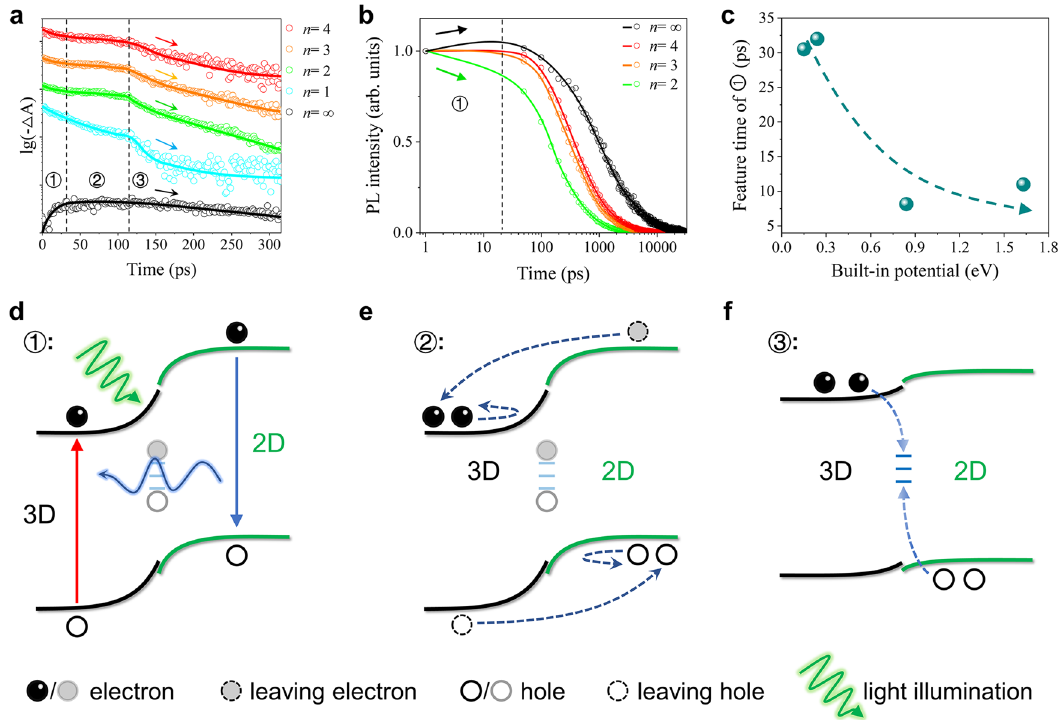
Fig. 3 | Carrier dynamics ofthe 2D/3D HP interface. a StagedTAkinetics probed atthe characteristicwavelengths ofdissimilarphases (520nm for n =1, 569nm for n =2,614nmfor n =3,644nmfor n =4,760nmfor n = ∞ ). b TransientPLkineticsof